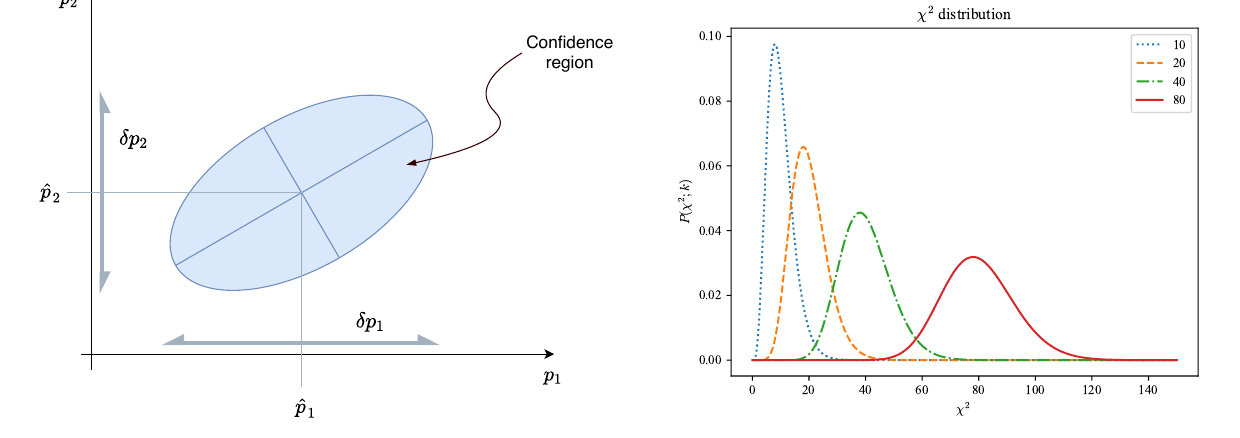
Figure 2. The χ 2 distribution for k degrees of freedom.